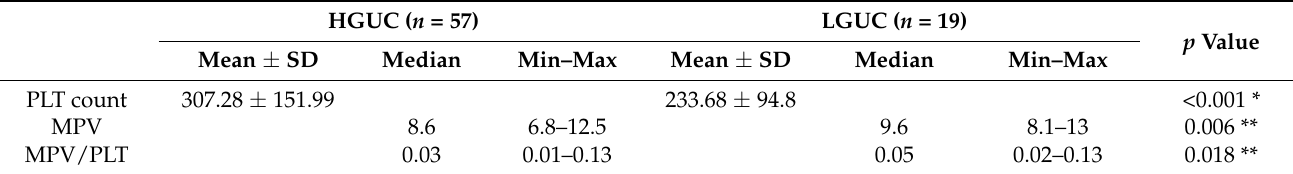
Table 4. Comparison of mean platelet count, mpv and mpv/plt among patients with HGUC and LGUC.